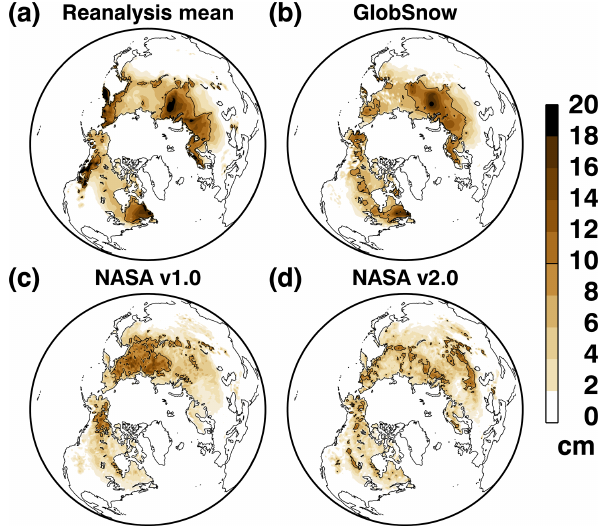
Figure 1. Mean January, February, and March (JFM) SWE over the 2003–2010 period for (a) four reanalysis-driven products (GLDAS- 2, ERA-Interim/Land, Crocus and MERRA-2), (b) GlobSnow v2.0, (c) NASA AMSR-E SWE v1.0, and (d) NASA AMSR-E SWE